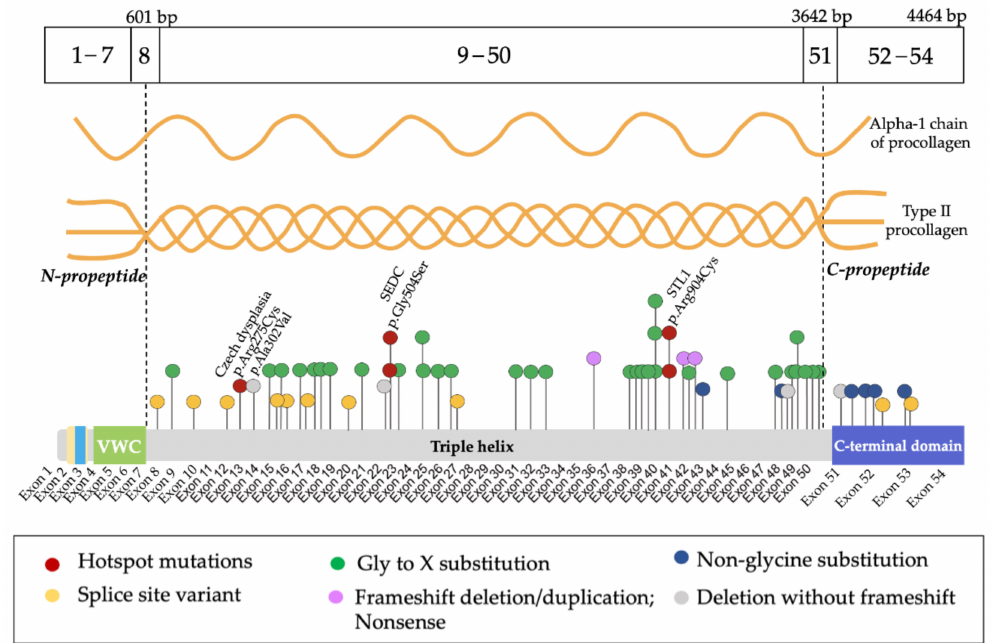
Figure 2. Variants localization in exons of the COL2A1 gene and distribution of amino acid substitu- tions in protein domains. Variant c.905C>T (p.Ala302Val) has been defined into a gray group since it leads to a non-frameshift deletion [29].